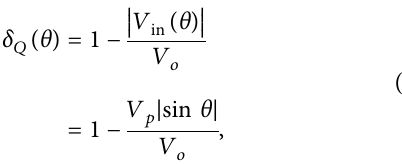
Figure 5: Theoretical waveform second-stage resonant isolated DC/DC